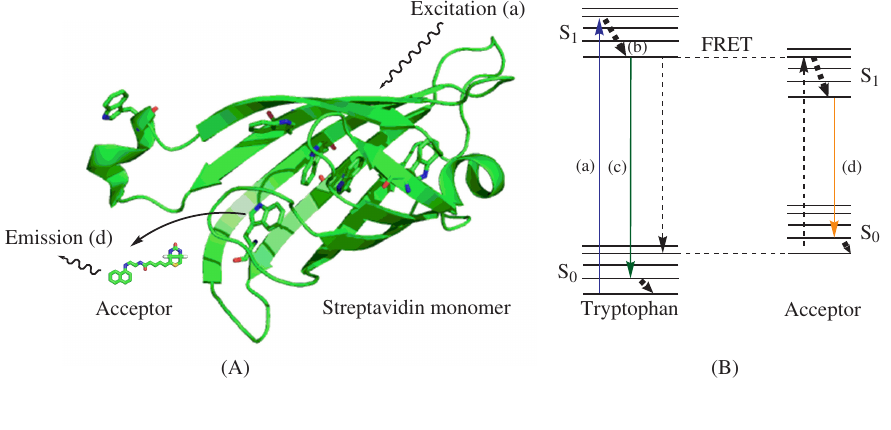
Table 2. Intrinsic tryptophan fluorescence as the FRET donor with the BNEDA probe [75].